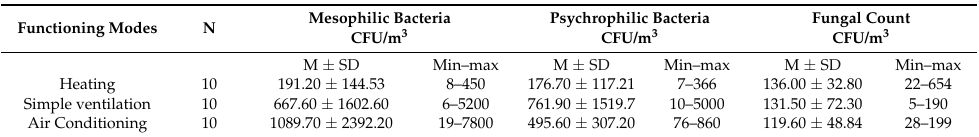
Table 1. Total microbial concentrations measured in the offices during heating, air conditioning, and simple ventilation.